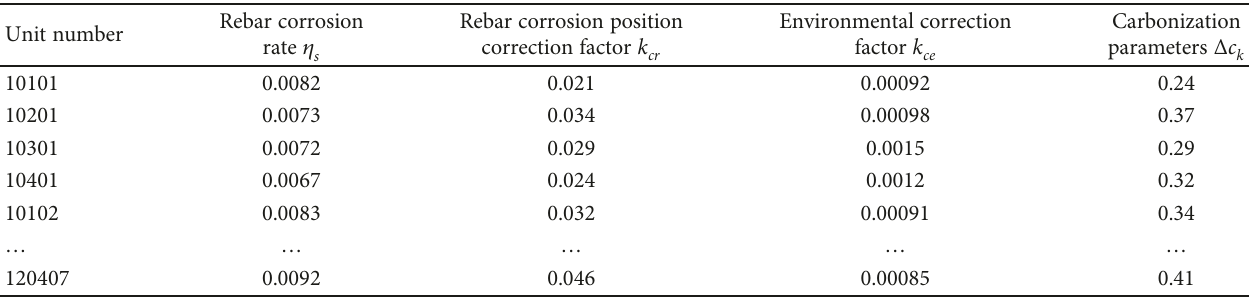
Table 3: Structural deterioration